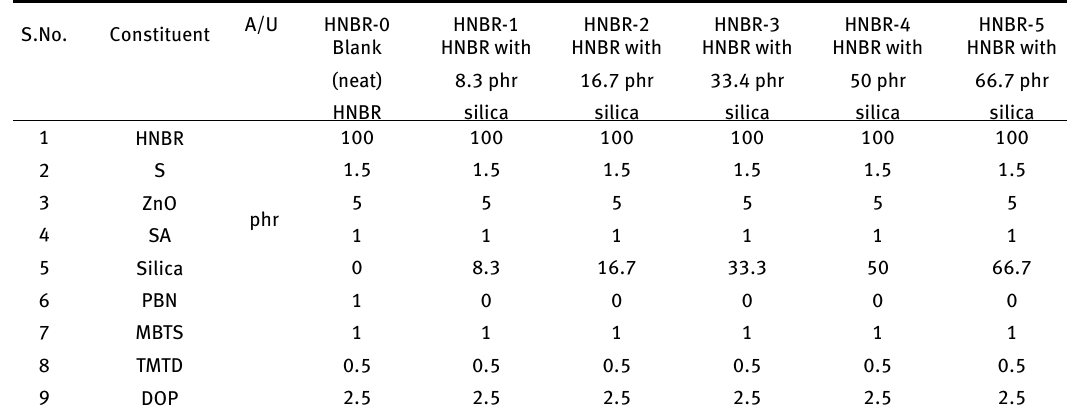
Table 1: HNBR Composites formulation recipes